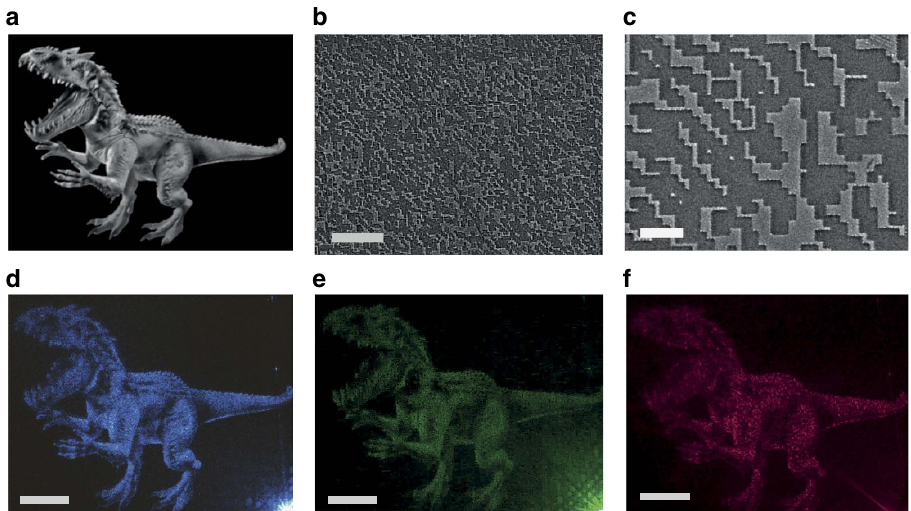
Figure 4 | Nanometric Sb 2 Te 3 thin film holograms and reconstructed images. ( a ) Original image of the dinosaur object. Note: this figure is not included under the article CC BY licence; Indominus Rex image is reproduced with permission from the publisher Comingsoon.net and copyright owner Universal Studios. ( b , c ) SEM images of the laser printed hologram patterns. The scale bar is 50 m m for b and 10 m m for c , respectively. ( d – f ) Holographic images captured by illuminating the nanometric holograms using 445, 532 and 632nm continuous wavelaser beams. Scale bars for d – f are